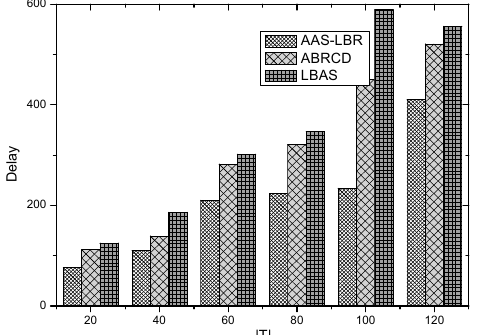
Figure 49. The impact of | T | with fixed network nodes = 900 with fixed on the delay.